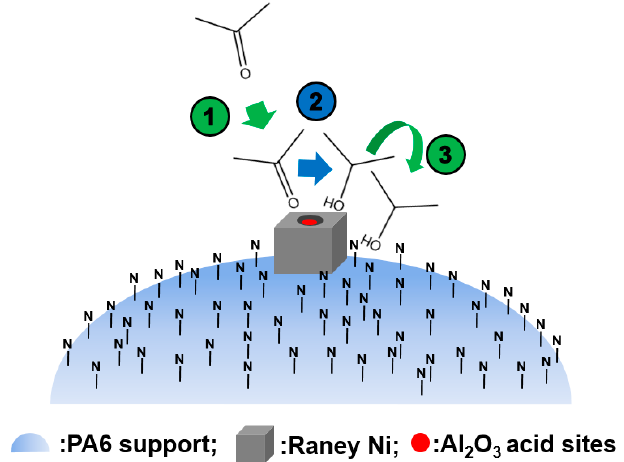
Figure 5. Schematic representation of the elimination of isopropyl ether over Raney Ni/PA catalyst. Reproduced from [18] with permission from Jiang H., Sci. China Chem.; published by Springer, 2016. The byproduct MIBC was generated through the reaction processes shown in Figure 6 [39].